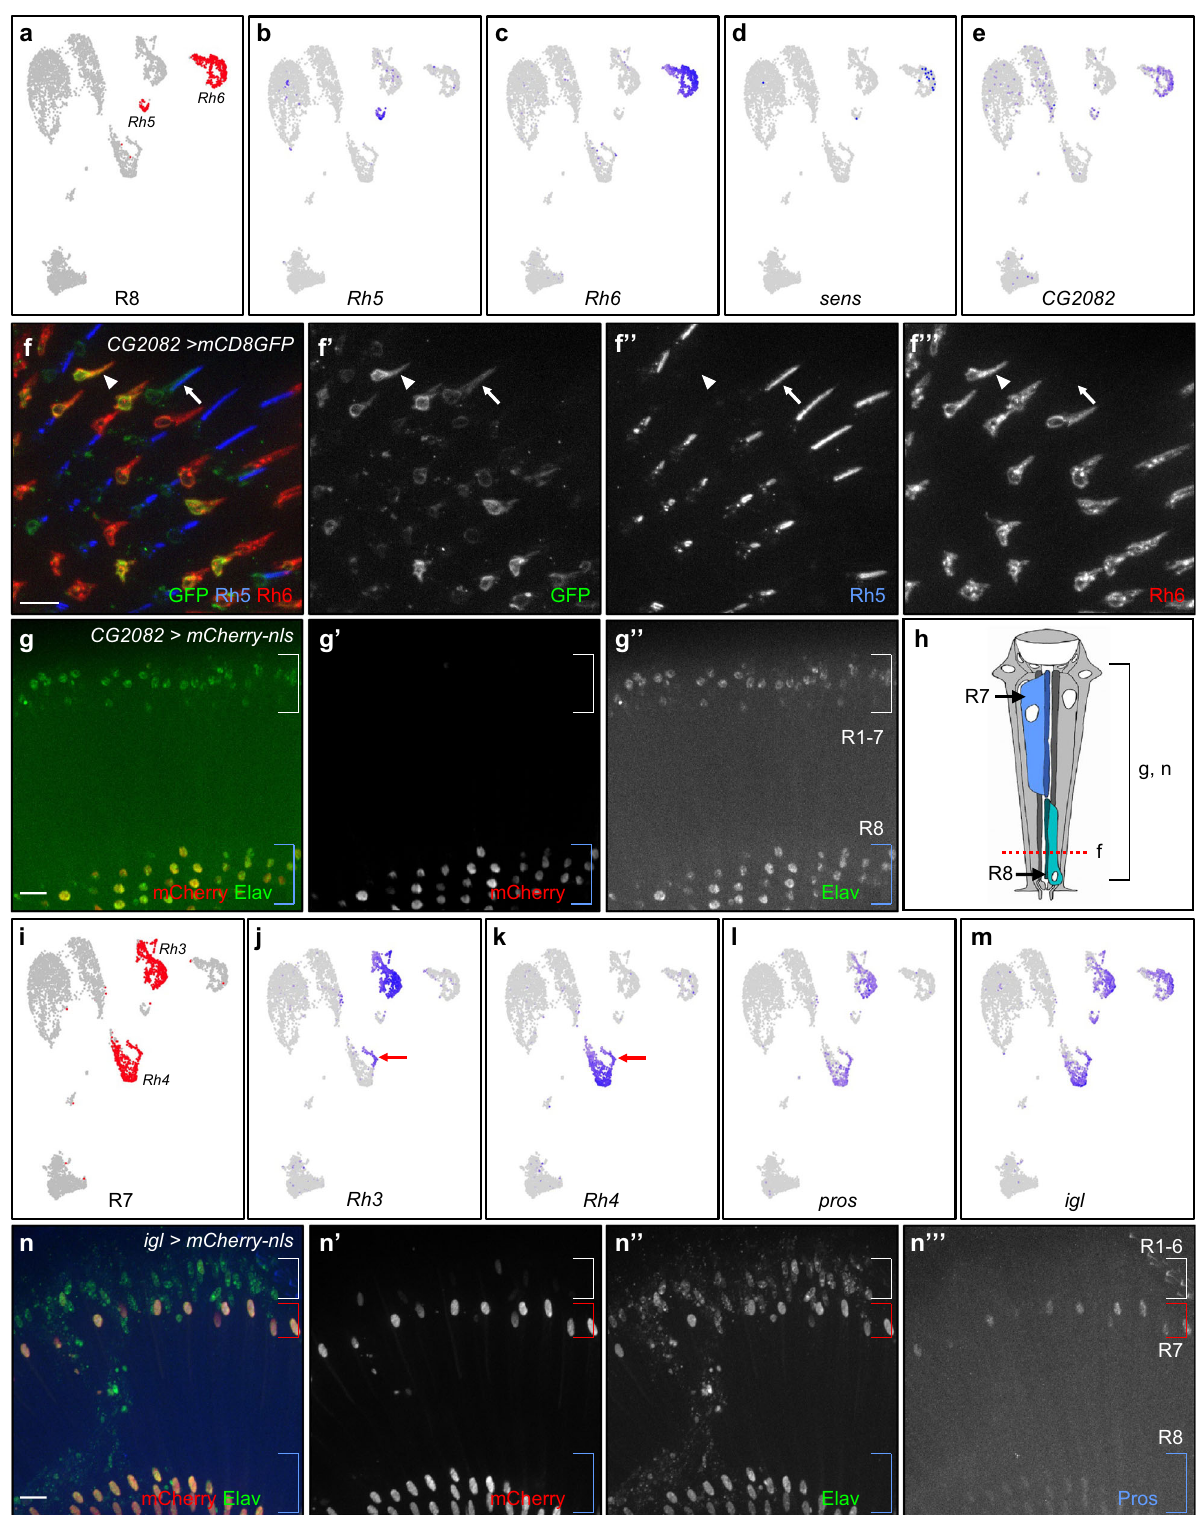
( igl , Fig. 2m, Supplementary Fig. 3e). To our knowledge, igl expression in adult R7 and R8 was not previously reported in vivo. To test if igl is speci fi cally expressed in R7 and R8 in vivo, mCherry-nls was driven with igl-T2A-Gal4 . Immuno fl uorescence staining shows that igl driven mCherry is speci fi cally expressed in both R7 and R8 in the eye (Fig. 2n). To our knowledge, igl has not been shown to be expressed in adult R7 and R8